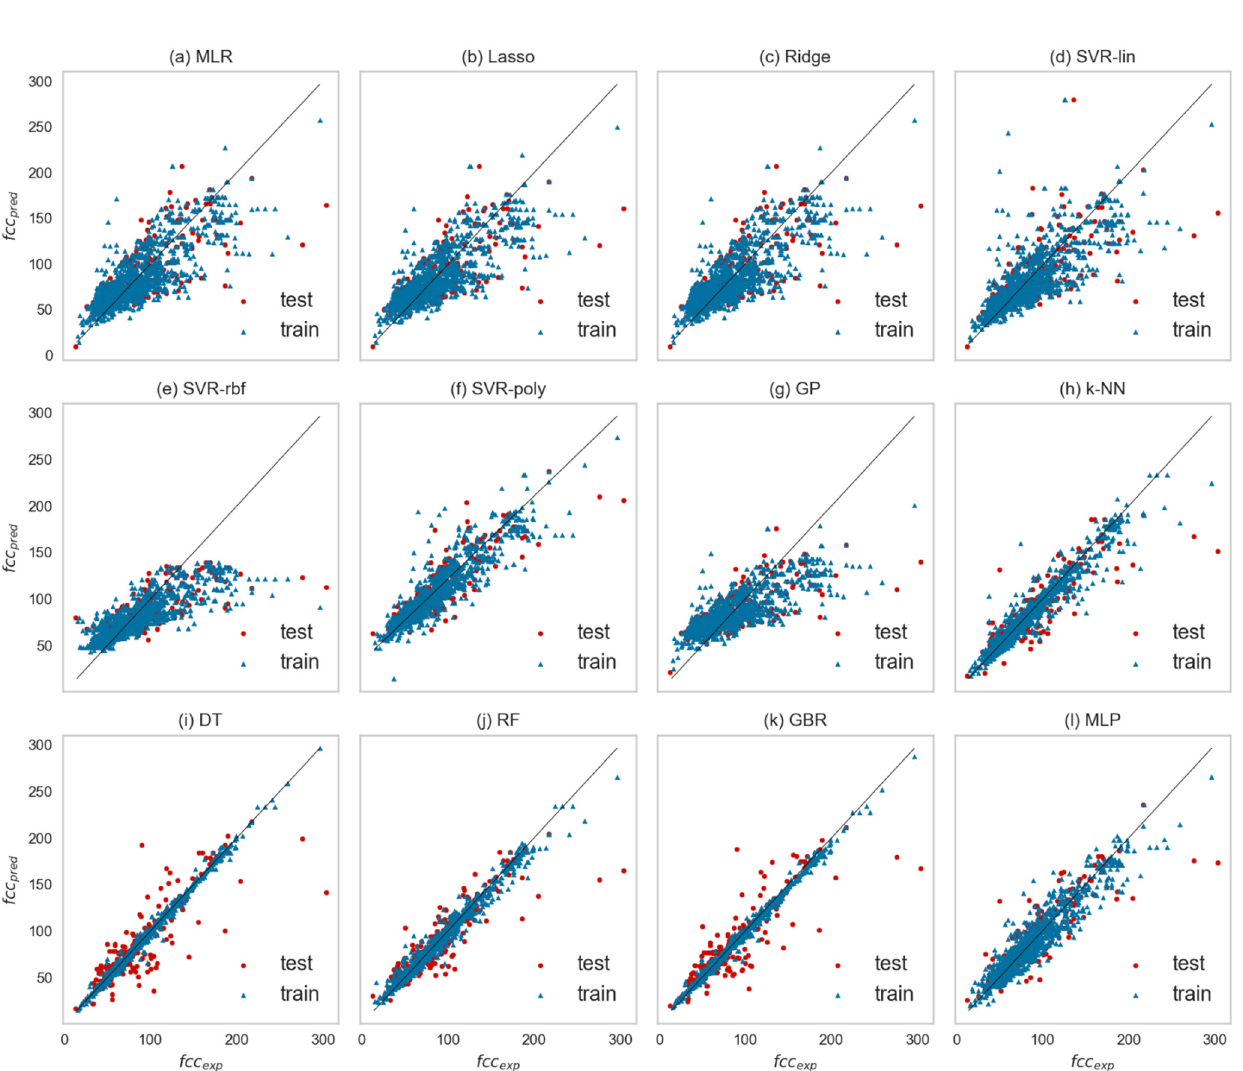
Figure 6. Experimental versus predicted values for f cc (both training and test data, after the incorporation of six PCA inputs instead of the original eight) in identity plots being the output of 12 different algorithms, ( a ) MLR, ( b ) LASSO, ( c ) Ridge, ( d ) SVR-linear kernel, ( e ) SVR-RBF, ( f ) SVR- polynomial, ( g ) GP, ( h ) k-NN, ( i ) DT, ( j ) RF, ( k ) GBR, and ( l ) MMLP. The 45° line shows the per-